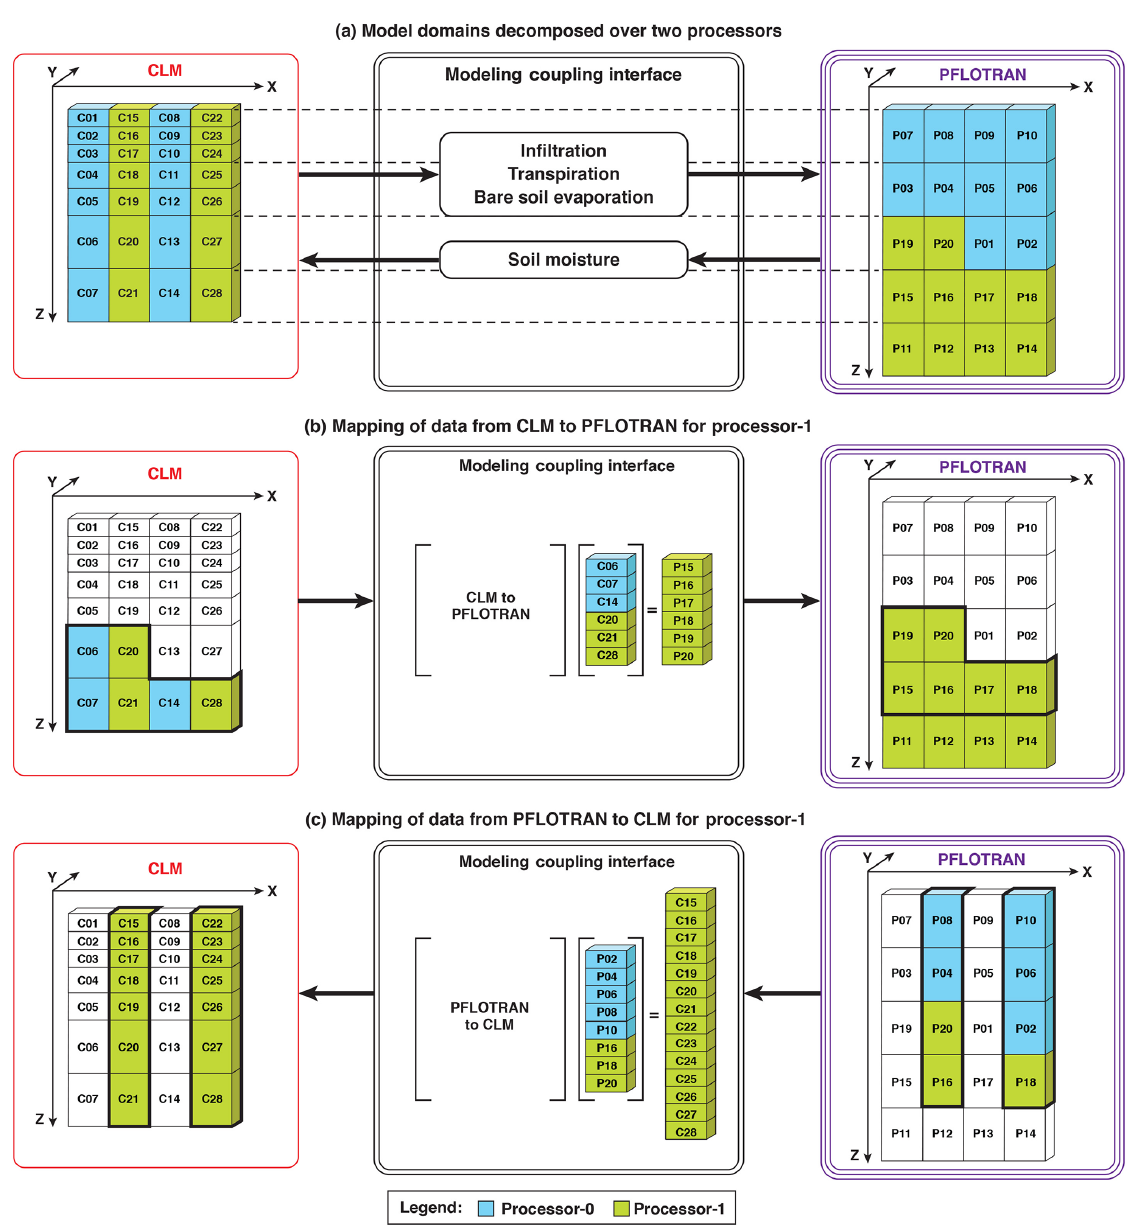
Figure 1. Schematic representations of the model coupling interface of CP v1.0. (a) Domain decomposition of a hypothetical CLM and PFLOTRAN domain comprising of 4 × 1 × 7 and 4 × 1 × 5 grids in x , y , and z directions across two processors, as shown in blue and green. (b) Mapping of water fluxes from CLM onto PFLOTRAN domain via a local sparse matrix vector product for grids on processor 1. (c) Mapping of updated soil moisture from PFLOTRAN onto CLM domain via a local sparse matrix vector product for grids on processor 1.